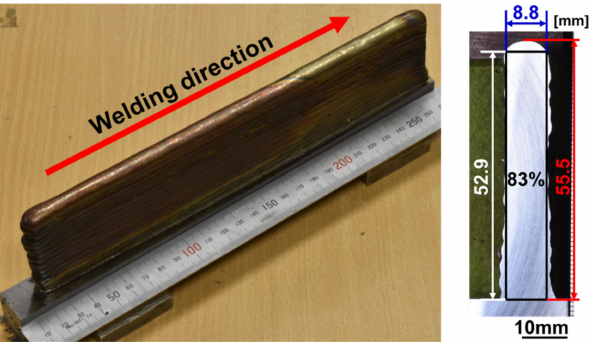
Figure 10. Appearance and cross-section of 15-layer large wall-type sample with measured values of effective height, maximum height, effective width, and near net shape rate.